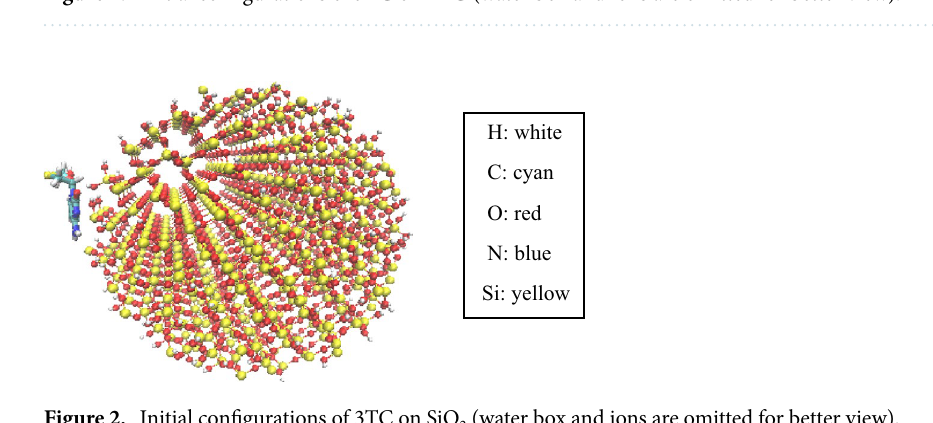
Figure 1. Initial configurations of 3TC on PEG (water box and ions are omitted for better view).